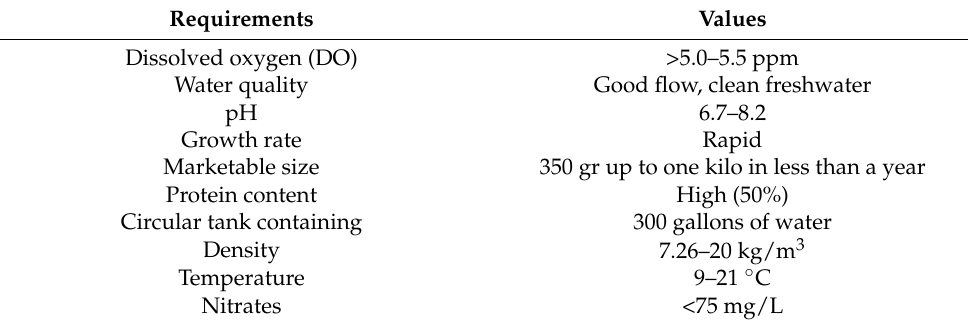
Table 1. Requirements of rainbow trout in closed farming systems [34,36,56,209,222,223]. Requirements Values Dissolved oxygen